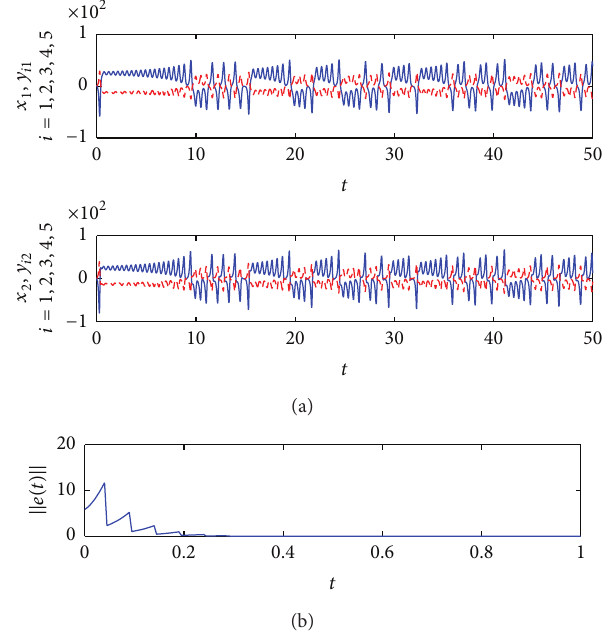
Figure 9: Evolution of (a) state trajectories of drive (the dash line) and response systems (the solid line) and (b) projective synchronization error under impulsive